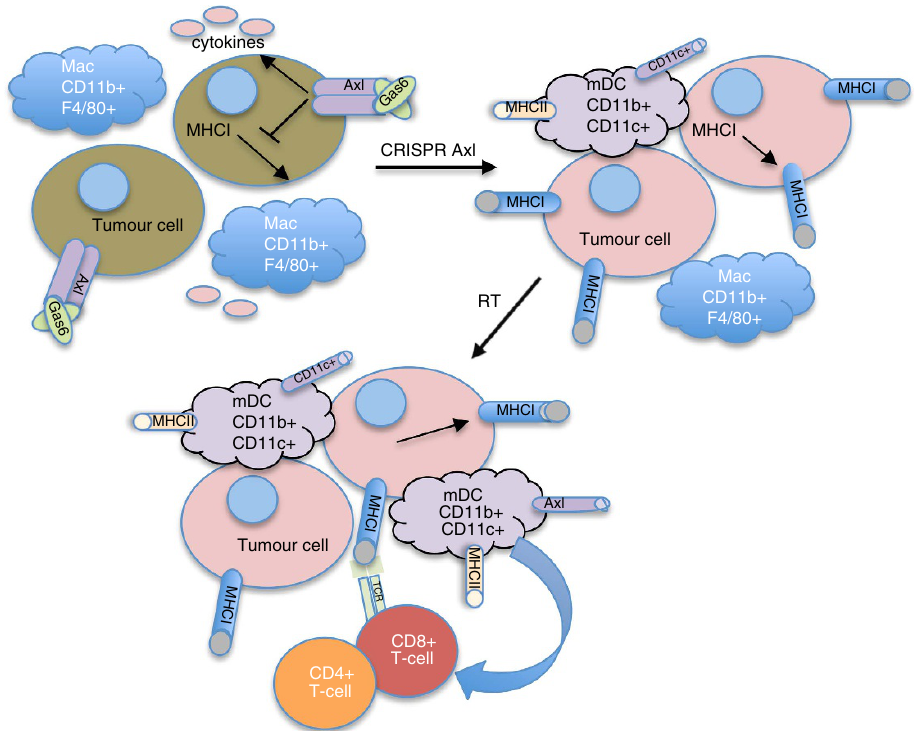
Figure 6 | Loss of Axl enables licensing an antitumour immune response after RT. With high expression of Axl, there is low MHCI expression and tumour cells release myeloid promoting cytokines and chemokines. With the loss of Axl, MHCI expression increases and cytokine signaling is diminished leading to an immune response with increased CD11c þ and MHCII þ antigen presenting cells (mDC) and T-cells. The addition of RT licenses a robust antitumour immune response with decreased macrophages (Mac), increased proportion of antigen presenting cells, and a greater recruitment of CD4 þ and CD8 þ T-cells.